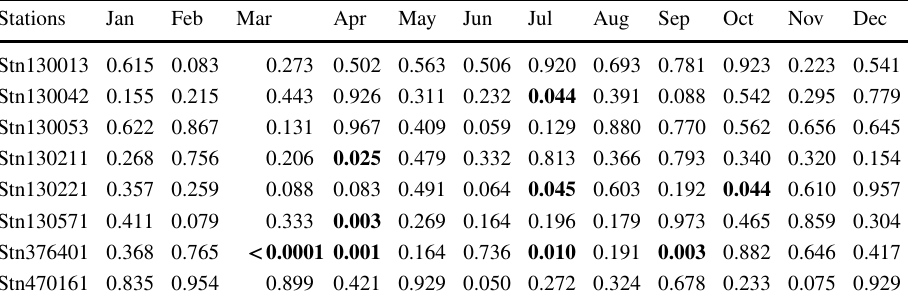
Bold number represents p < 0.05 indicating inhomogeneity in the corresponding time series at a 5% signifi-